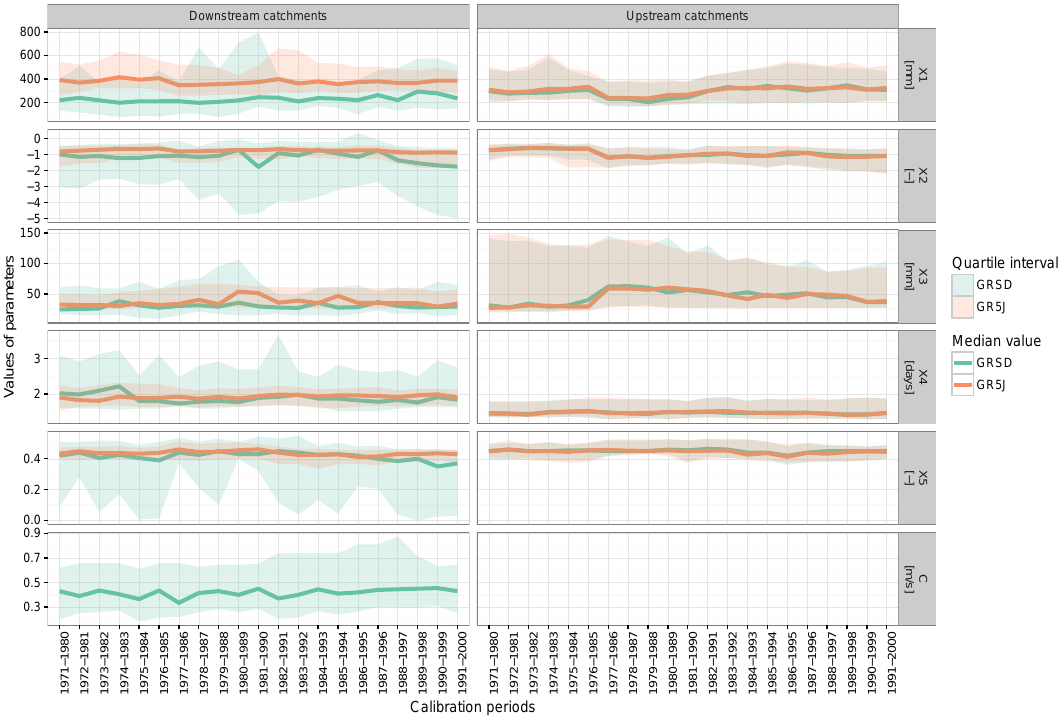
Figure 5. Quantile values of optimised parameter values according to the calibration periods for the 64 catchments. Upstream catchments are all headwater hydrological units, and downstream catchments are all the